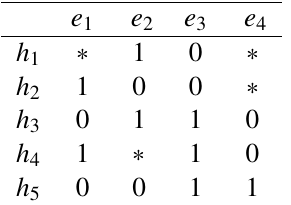
Table 1. The tabular representation of ( F , A )